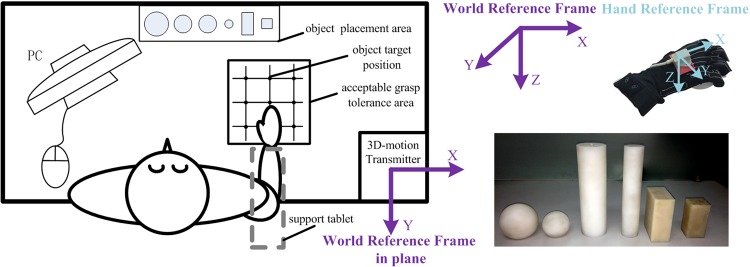
Experimental setup.